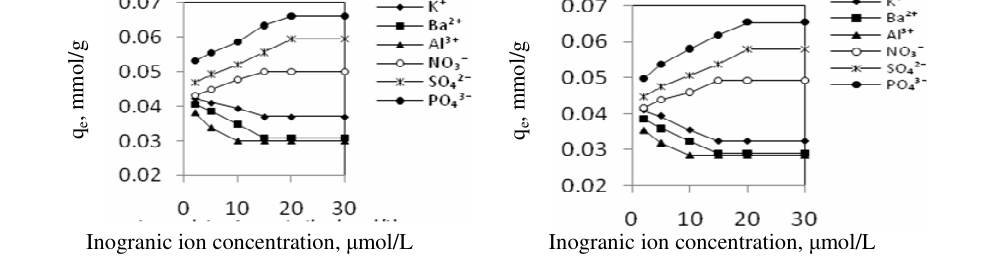
Figure 4. Plot of soium-palmitate adsorption in the presence of various inorganic lons at differeent concentrations and charges for hematite